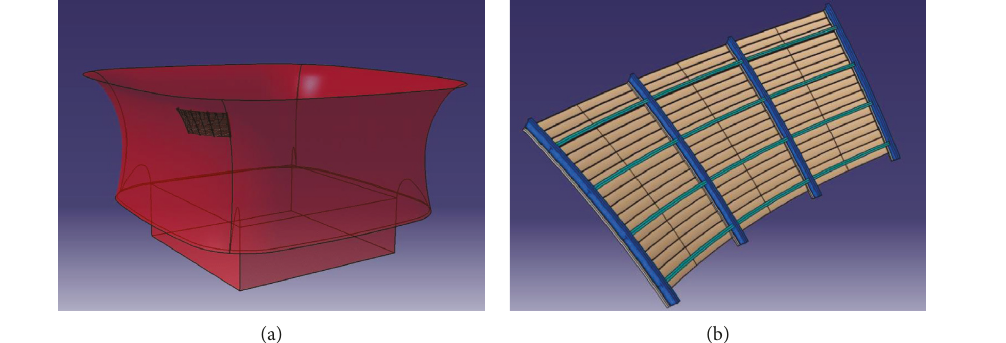
Figure 3: Design model: (a) preliminary concept model and (b) DD stage design model.